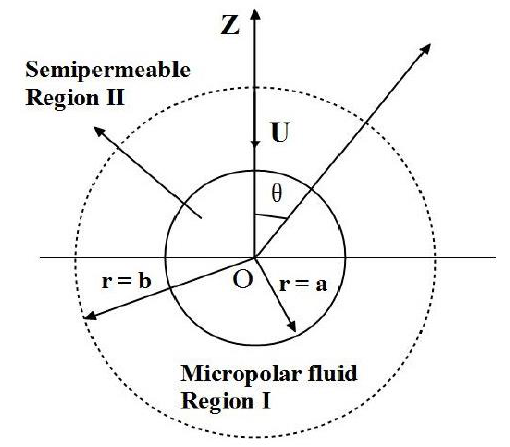
Figure 1. Geometry of the